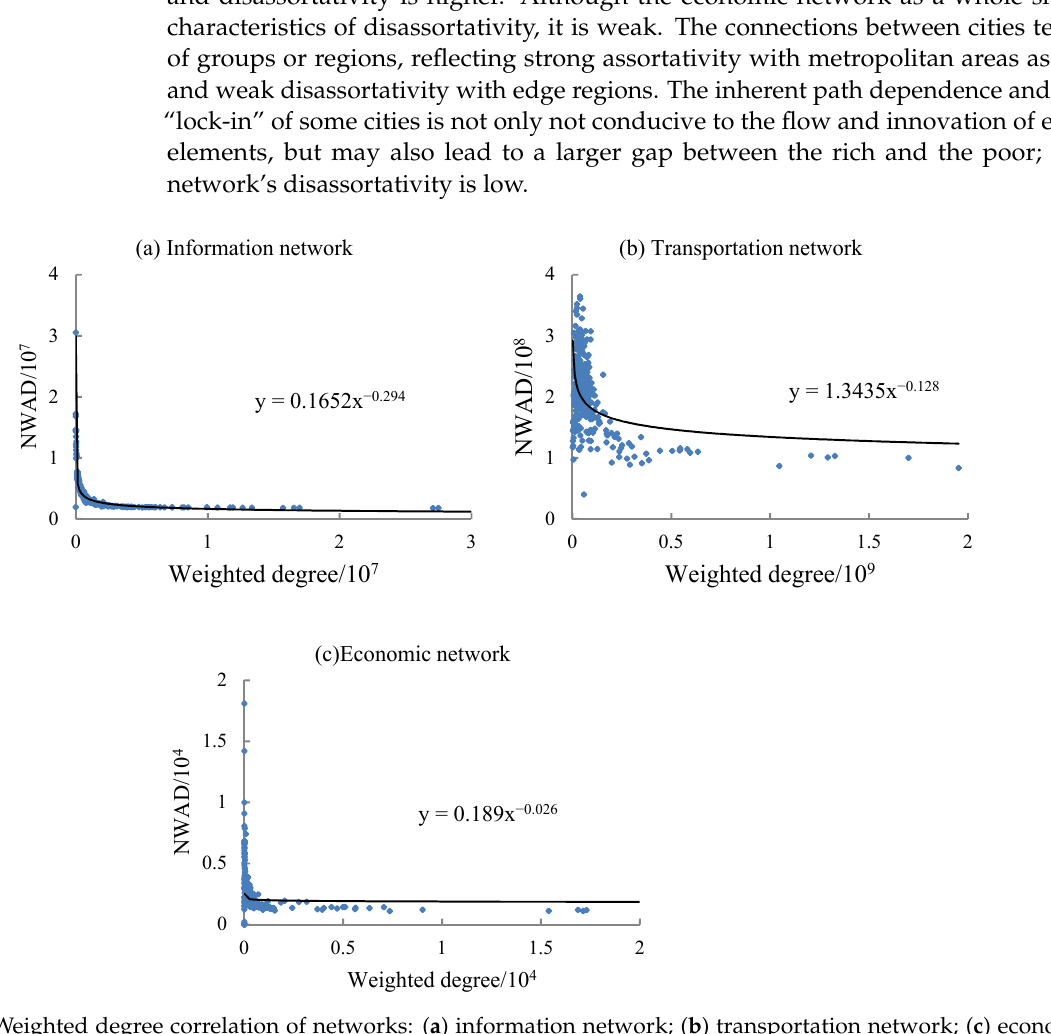
Figure 6. Weighted degree correlation of networks: ( a ) information network; ( b ) transportation network; ( c ) economic network.